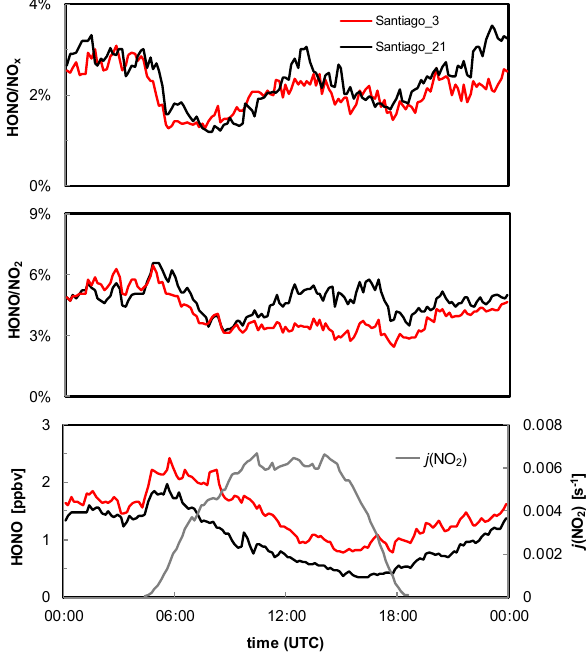
Fig. 2. Average diurnal cycles of HONO and NO x measurements at 6 (Santiago 3) and 53 (Santiago 21) meters altitude in Santiago de Chile, 2009, adopted from Villena et al.